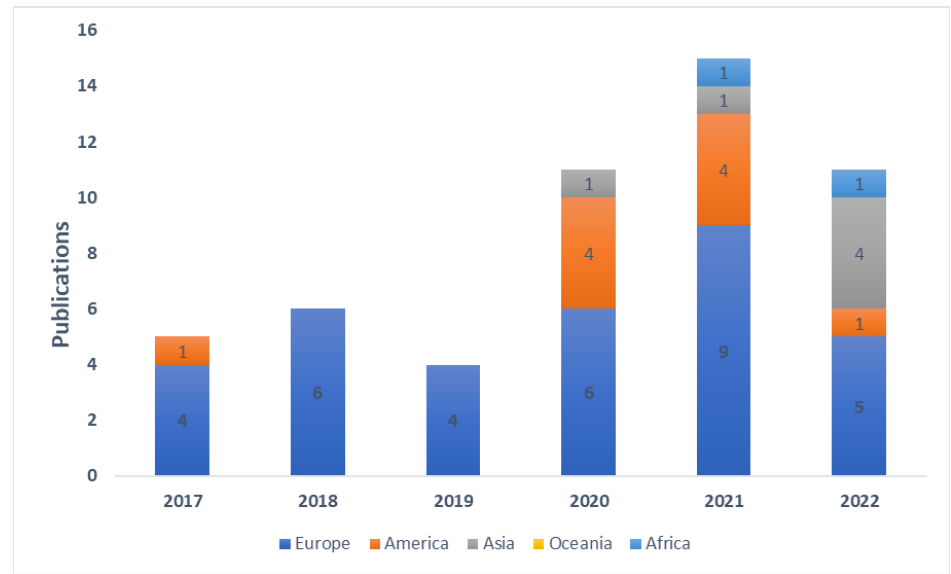
Figure 2. The number of studies analyzed by year and region. Source: Prepared by the authors. The European continent accounts for 64% of the publications, with Italy (9) and Spain (7) having the most publications.